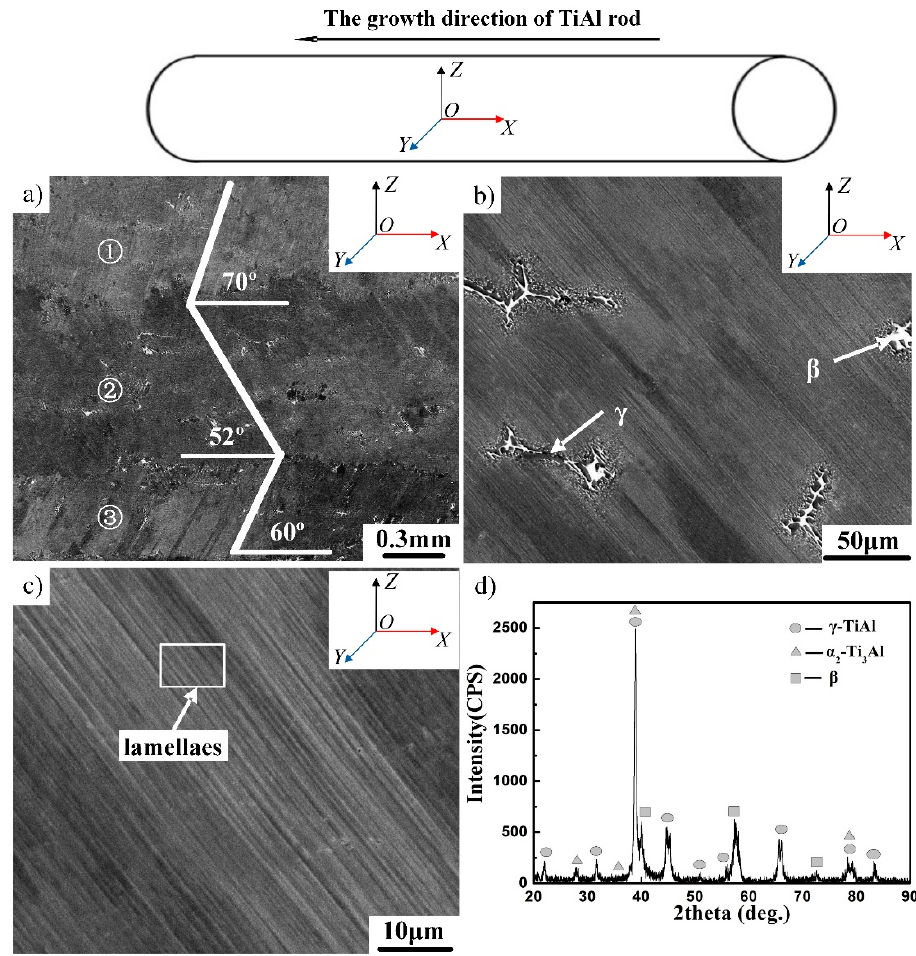
Figure 2. Microstructure and X-ray diffraction (XRD) pattern of directionally solidified Ti–43Al–2Cr–2Mn–0.2Y alloy. ( a ) Columnar crystal, ( b ) the distribution of β and γ phase, ( c ) lamellae, ( d ) XRD pattern. TEM observation was also conducted to investigate the directionally solidified